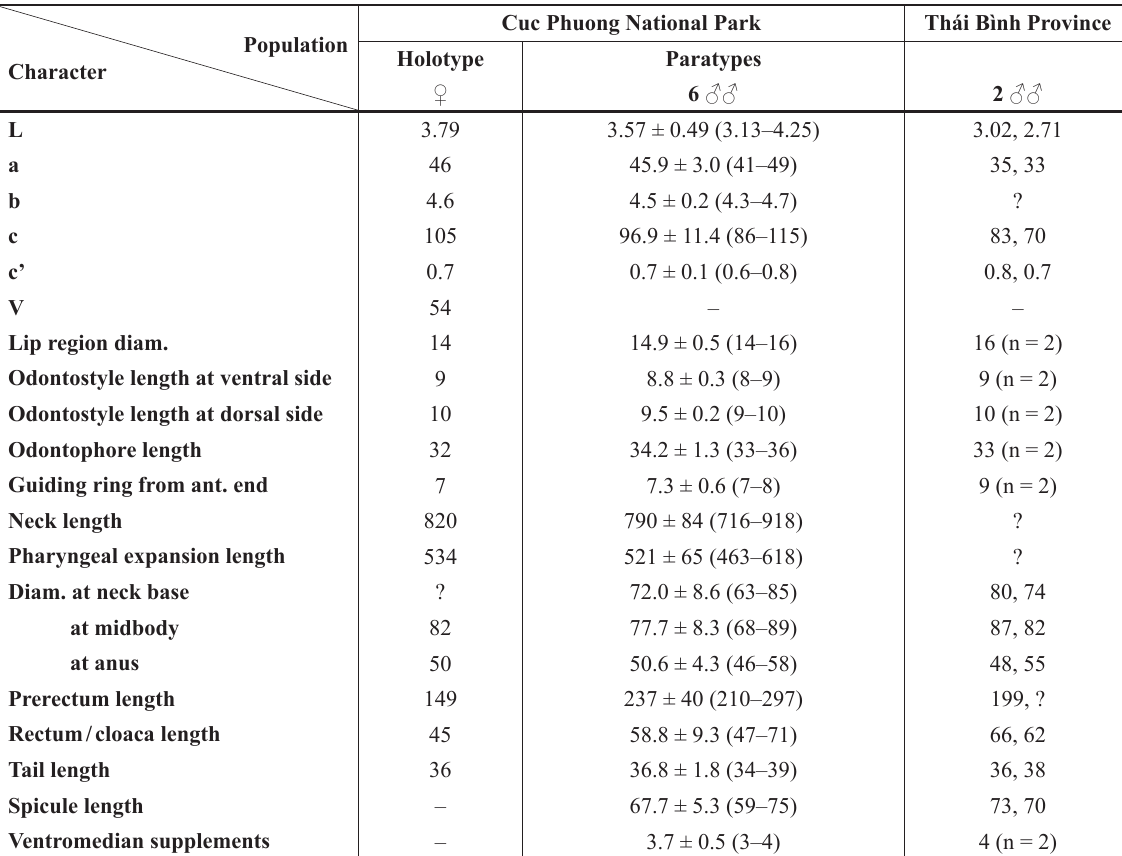
Table 2. Morphometrics of Sectonema vietnamense sp. nov. Measurements in μm (except L, in mm), and in the form: mean ± standard deviation